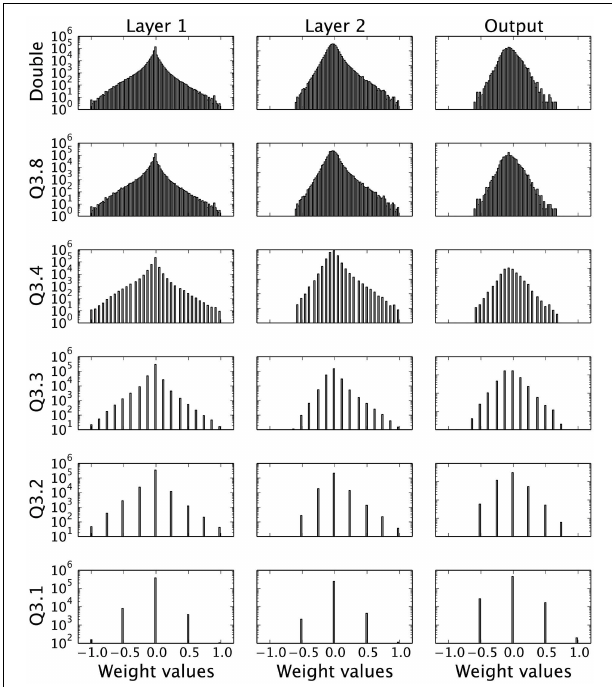
FIGURE 5 | Weight distributions for different bit precision levels and DBN layers. Each row represents different fixed-point weight precisions, while each column represents a layer of the DBN, starting from Layer 1 (left), Layer 2 (middle) to the Output Layer (right). Despite the different discretization levels, the overall shape of the weight distribution is